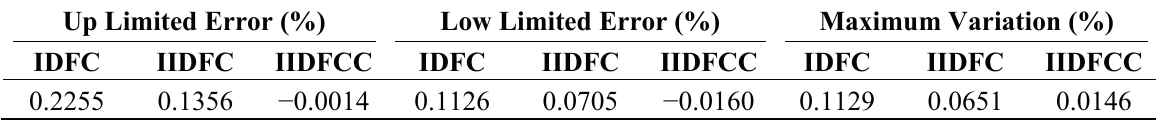
Table 1. R Error with one adjacent column element varied in 3–20 k Ω xy